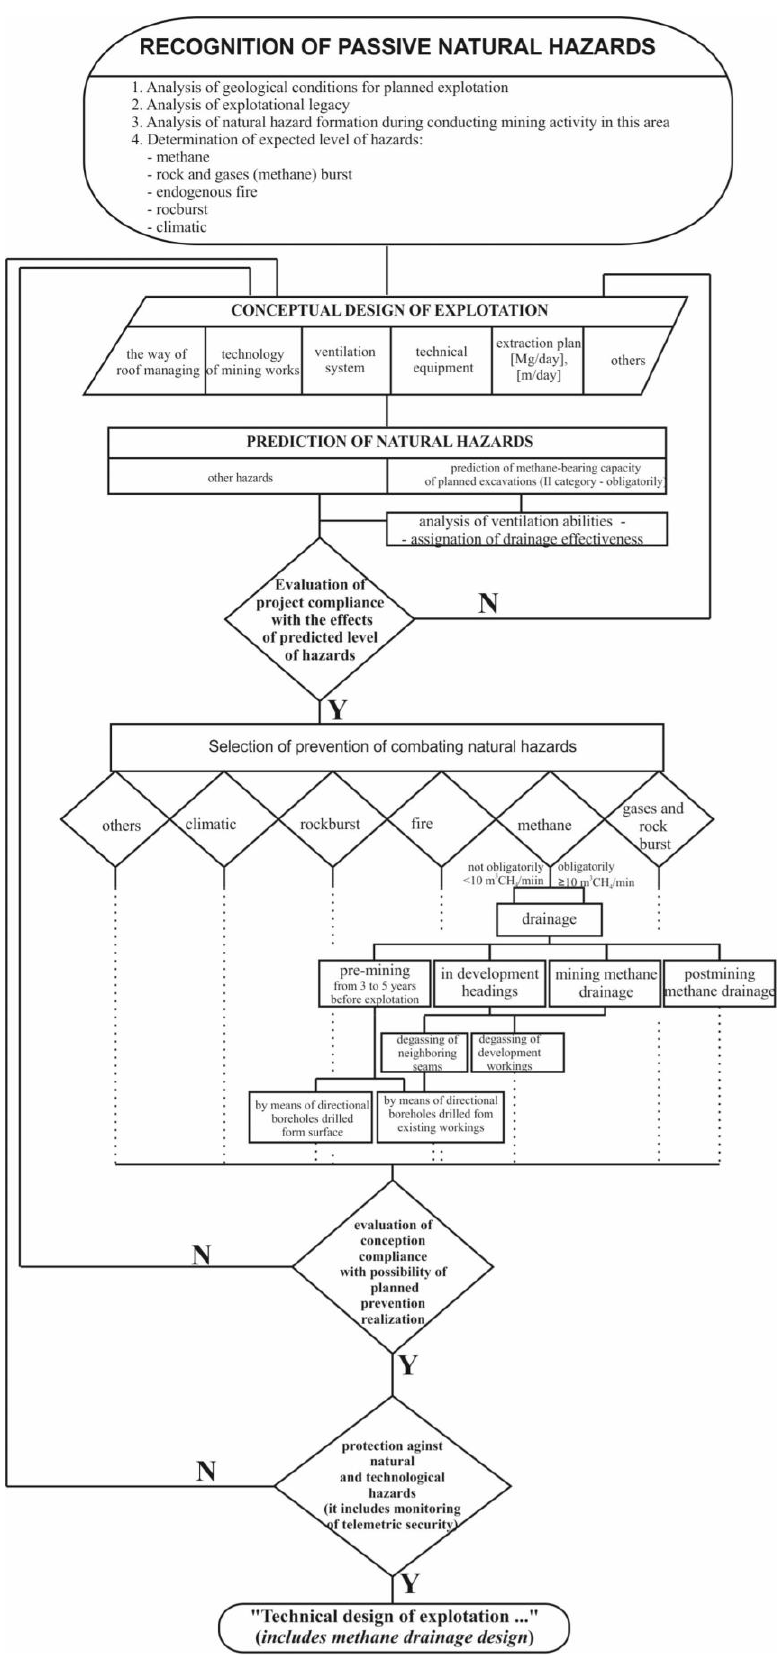
Figure 1. Exploitation design algorithm.